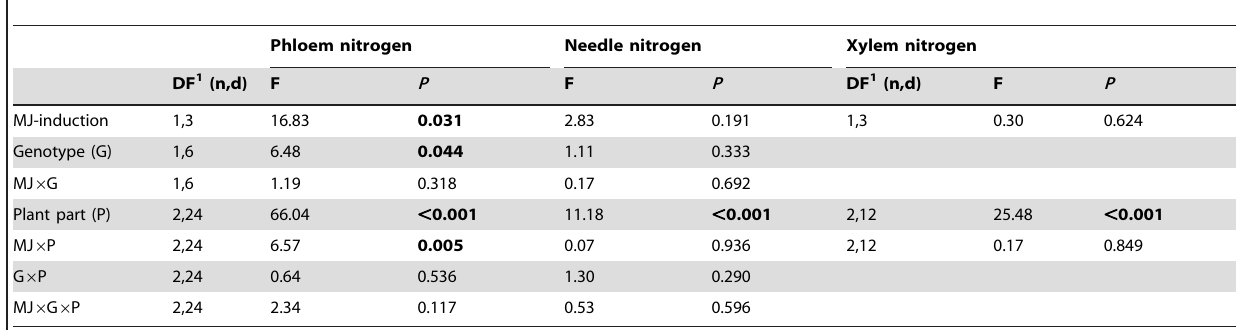
Table 3. Allocation of constitutive and induced concentration of nitrogen across different pine parts.